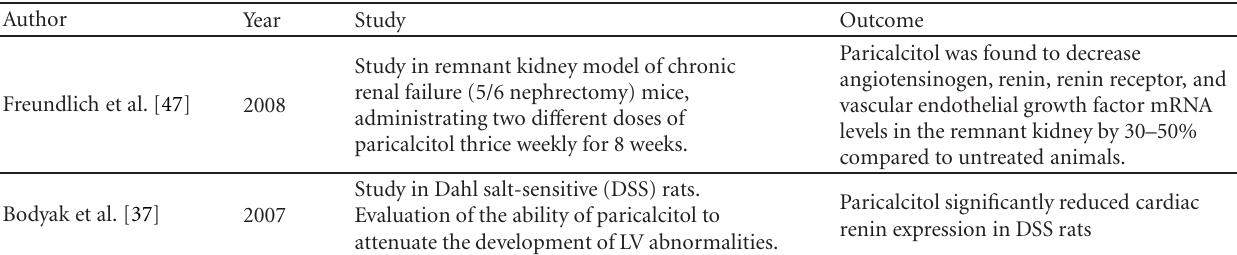
Table 11: Renal protection and inhibition of the rennin-angiotensin